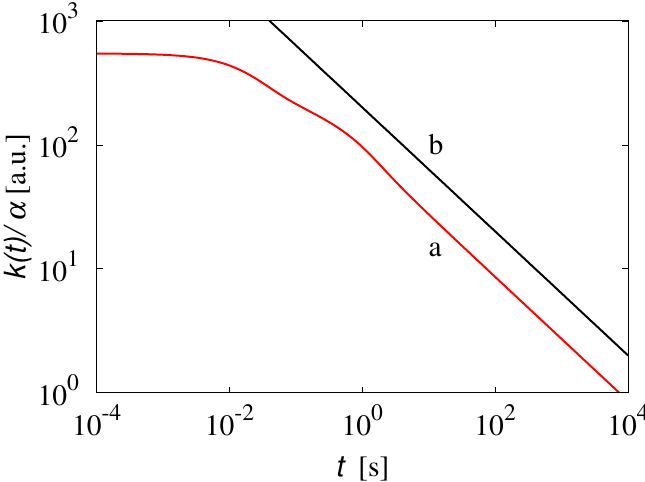
Figure 4. k ( t ) / α (line a) obtained from Equation (56) with N i = 2 modes. Line (b) corresponds to the √ t long-term scaling k ( t ) / α ∼ 1/